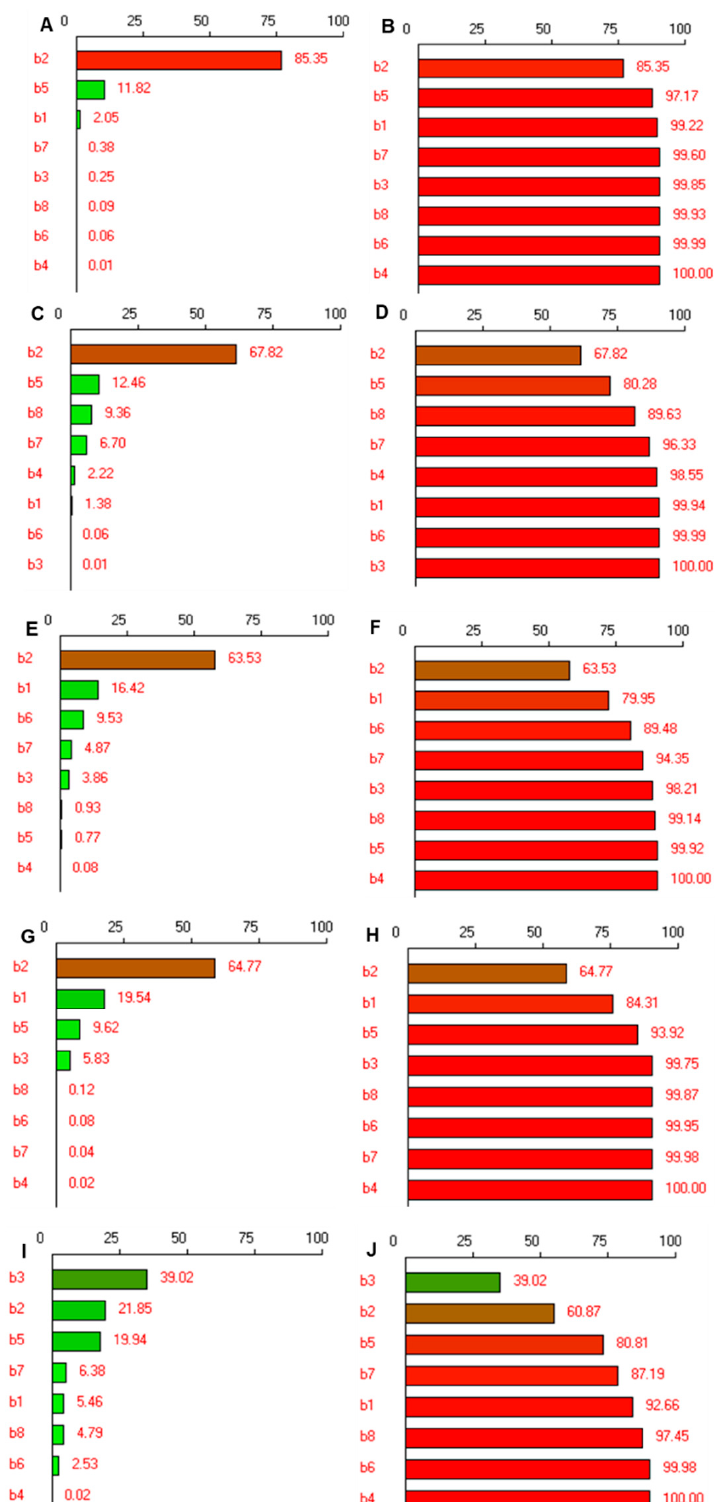
Figure 2. Pareto charts portraying the effect of selected critical formulation and process parameters on characteristics of efinaconazole spanlastic formulation. ( A , C , E , G , I ) and ( B , D , F , H , J ) represent individual and cumulative contribution (normalized squares, %) for particle size (Y 1 ), zeta potential (Y 2 ), relative deformability (Y 3 ), transmittance (Y 4 ), and encapsulation efficiency (Y 5 ), respectively. b1 to b8 represent the values of coefficients for the selected eight factors in the experimental design.